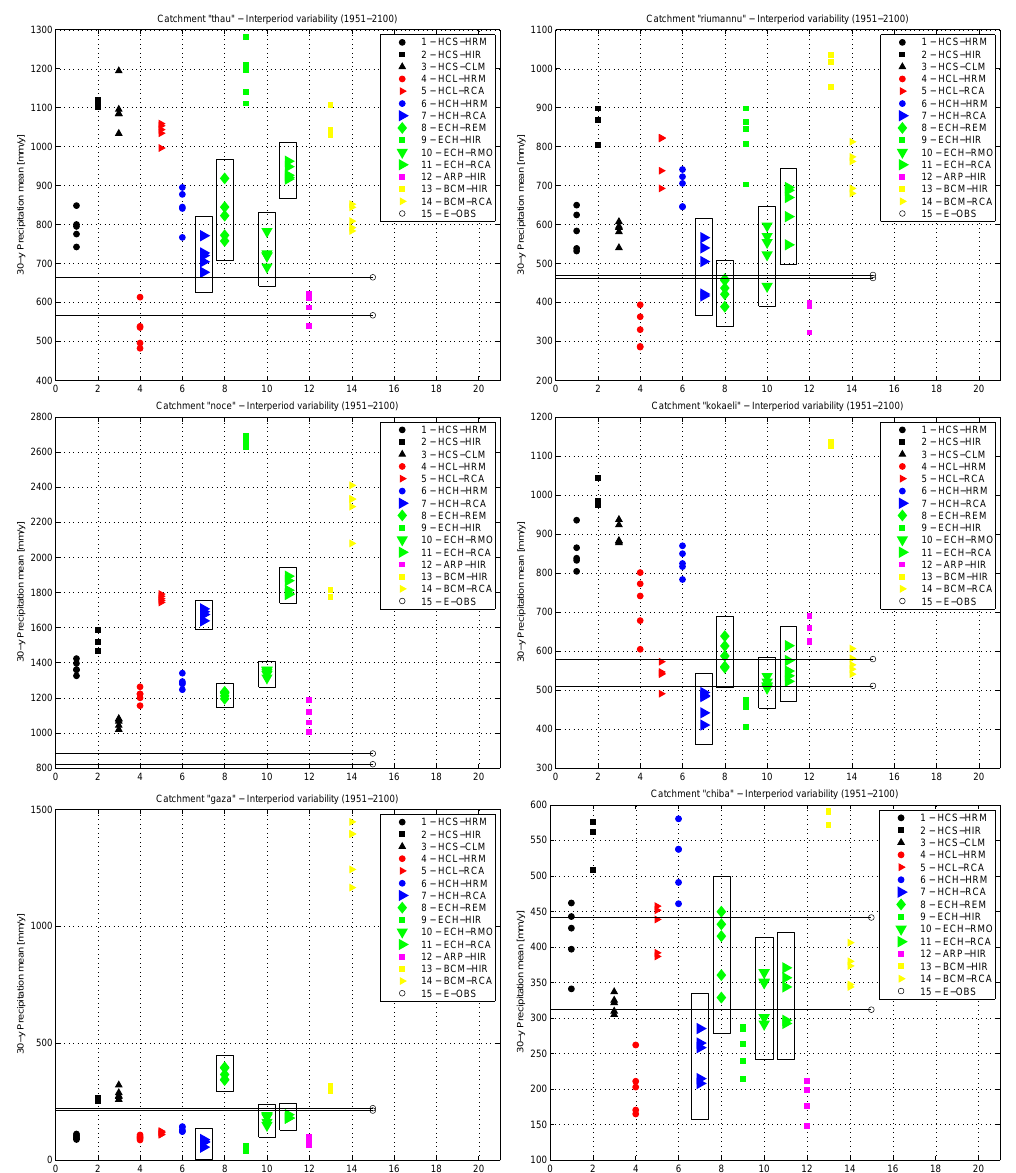
Fig. 9. Variability of the mean annual precipitation (mmyr − 1 ) over the five 30yr climatological periods between 1951 and 2100. Models HCS–HIR and BCM–HIR stop in year 2050. The reference values of E-OBS climatologies in the two 30yr periods between 1951–2010 are indicated with empty circles and horizontal lines. Each subplot displays results based on areal averages over a 4 × 4 grid-point stencil centered in each catchment.